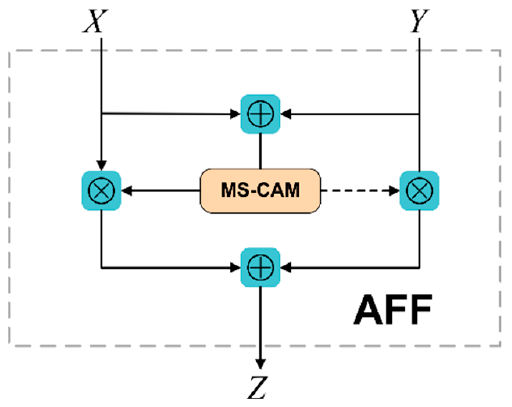
Figure 7. Structure of the AFF module.